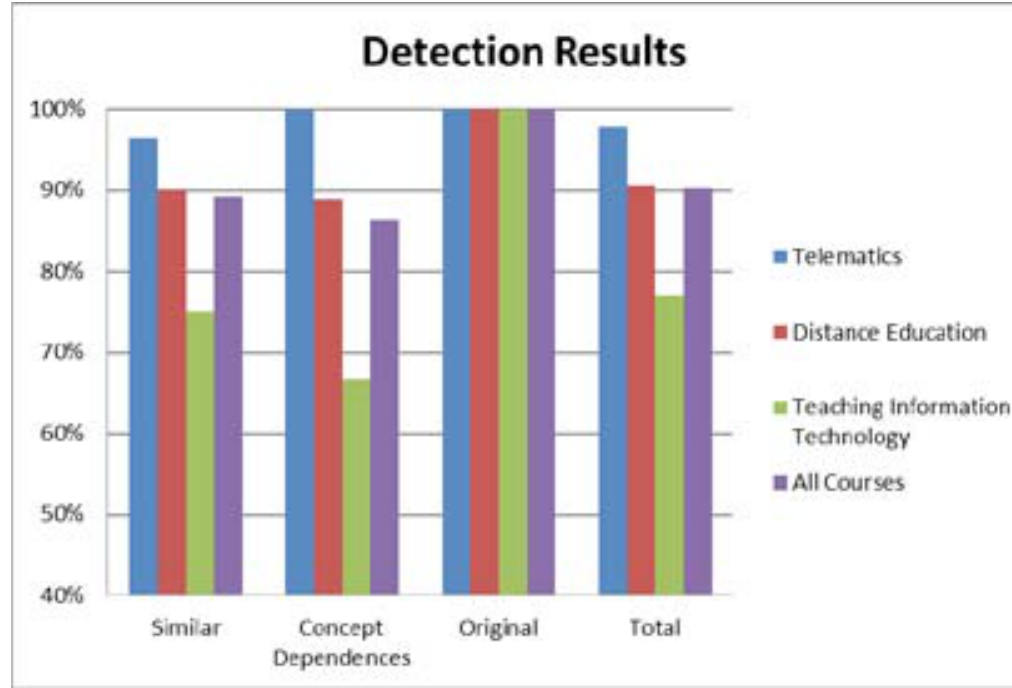
Figure 4 . Detection